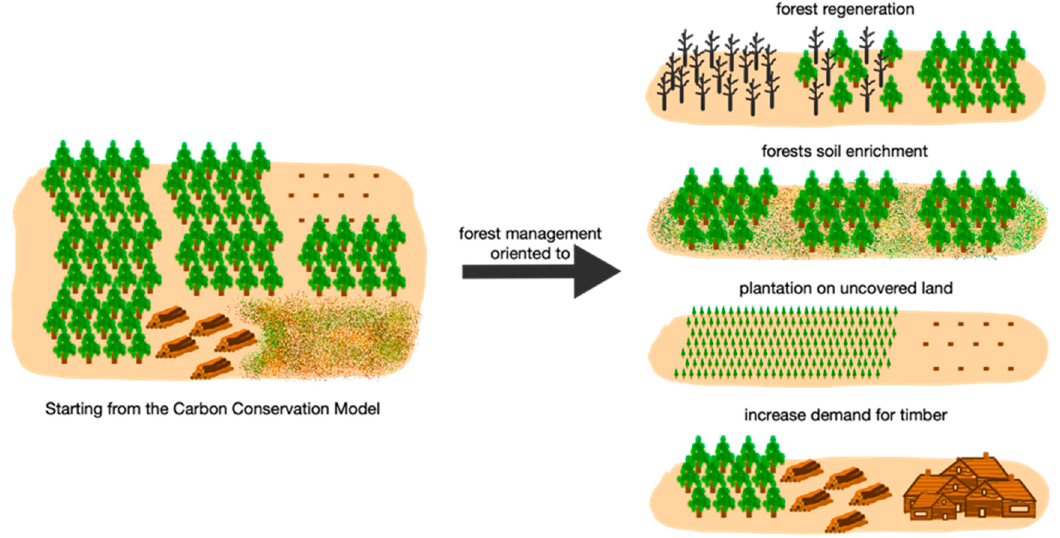
Figure 5. Forest management model for carbon storage (adapted from [136] ).